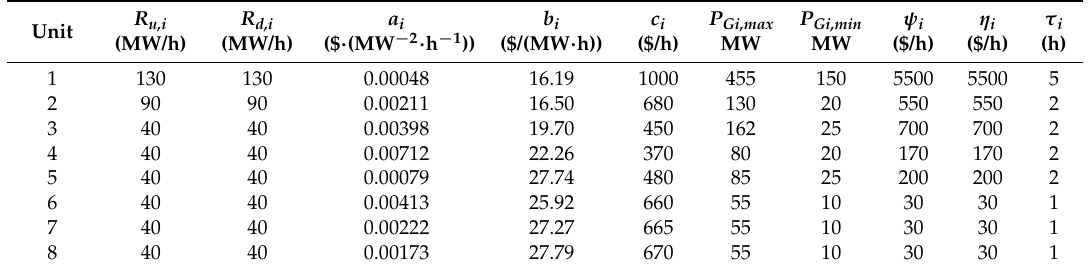
Figure 4. The predicted values of electricity load, thermal load and wind power. 334 Table 1. The parameters of conventional thermal power units. 335